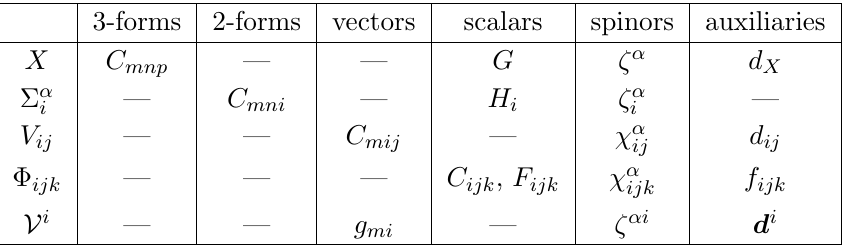
Table 4 . Component spectrum of Chern-Simons prepotentials. We present the component (cid:12)elds contributed by the gauged Chern-Simons hierarchy. As explained in the text, the bosons G , H i , and seven of the F ijk can all be removed by a choice of Wess-Zumino gauge. Similarly, the